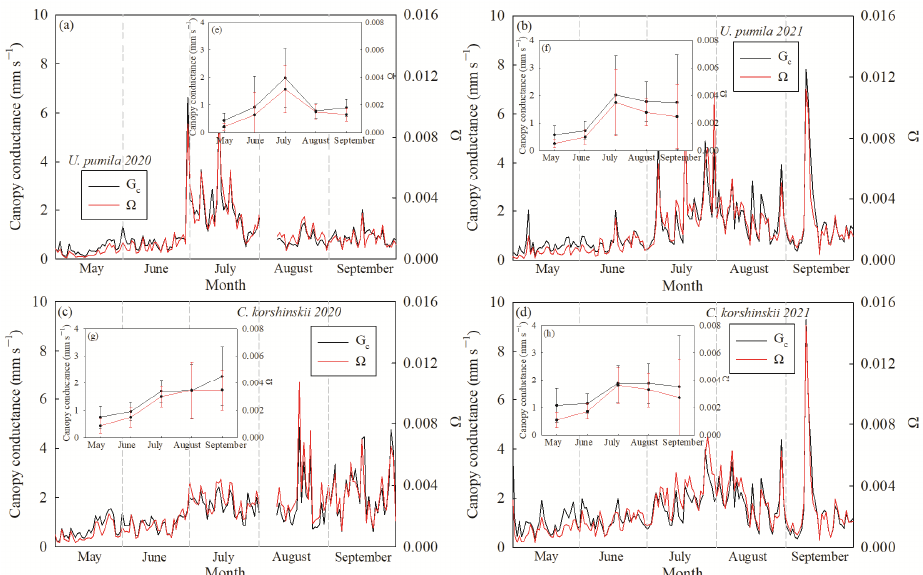
Figure 7. Seasonal variations in daily mean canopy conductance per ground area ( G c ) and mean decoupling coefficient ( Ω ) for U. pumila and C. korshinskii during the growing season of 2020 ( a , c ) and 2021 ( b , d ); monthly G c and Ω for U. pumila and C. korshinskii of 2020 ( e , g ) and 2021 ( f , h ).